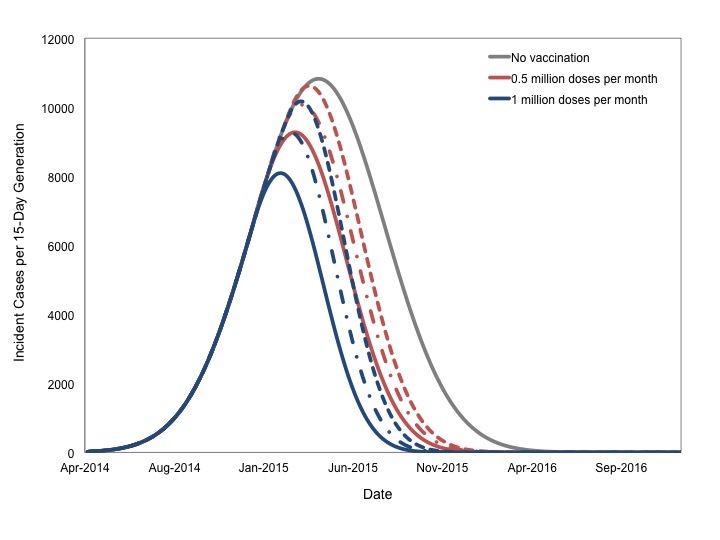
It is assumed that 10 million doses of vaccine are available for administration, and can be given either at a rate of 1 million doses monthly over 10 months (blue curves), or 500,000 doses monthly over 20 months (red curves), beginning in January (solid lines), February (dashed-dotted lines), or March (dashed lines) 2015.